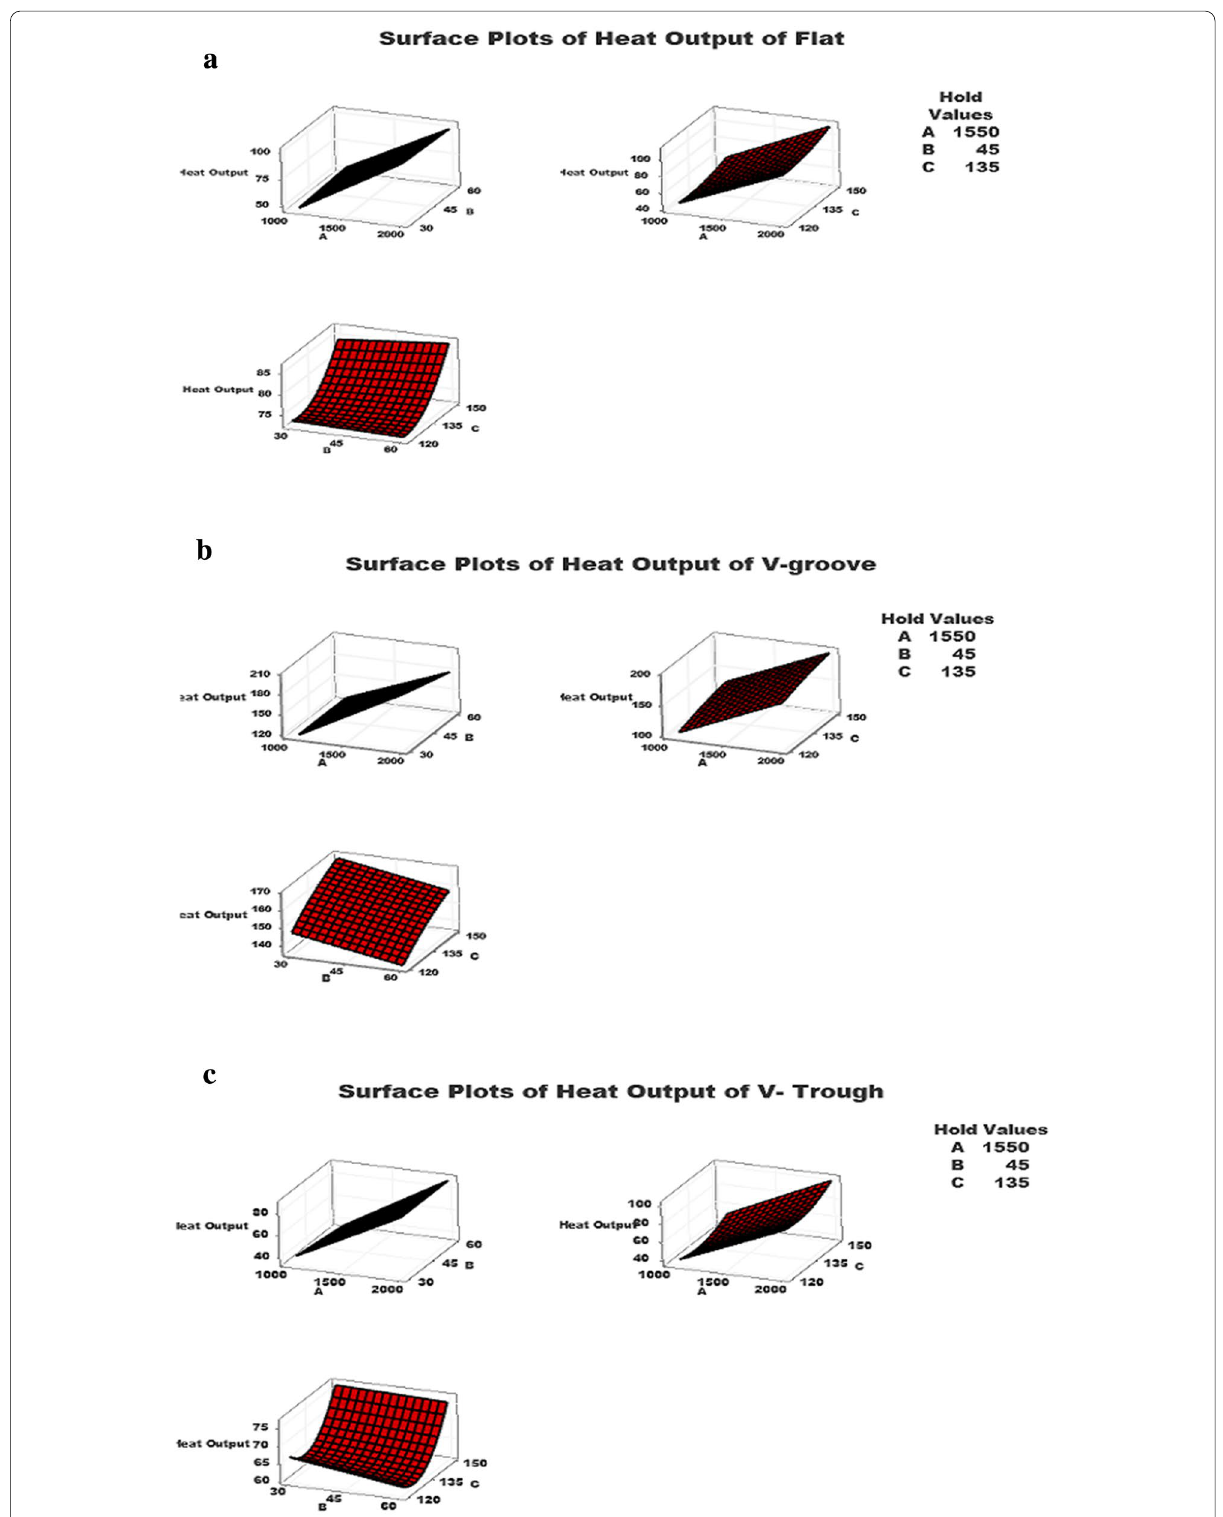
Fig. 5 3-D surface diagram of heat output for ( a ) flat, ( b ) V-grooved, ( c ) V-trough absorber